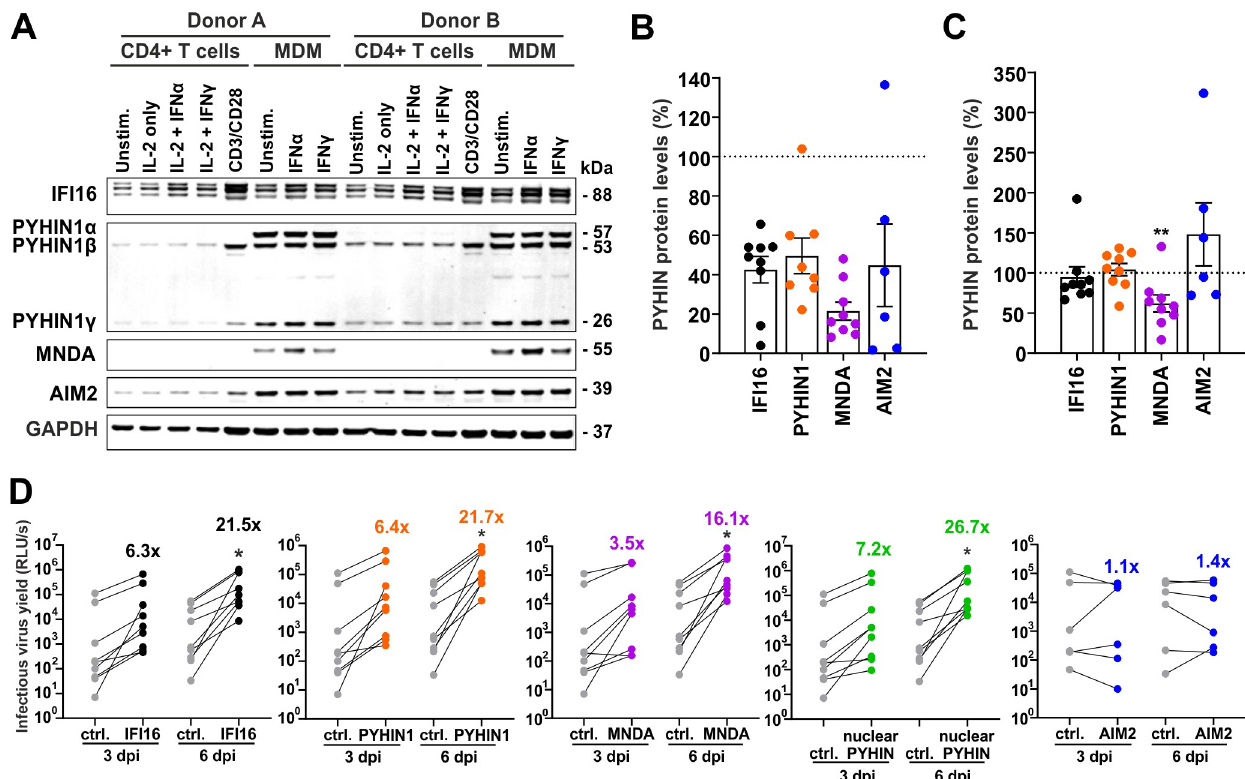
Fig 3. Nuclear human PYHIN proteins restrict HIV-1 in human macrophages. (A) Expression of PYHIN proteins in primary HIV-1 target cells. CD4+ T lymphocytes were stimulated with IL-2 alone, IL-2 + IFN α (500 U/ml), IL-2 + IFN γ (200 U/ml) or IL-2 + anti-CD3/CD28 beads. Macrophages (MDM) were stimulated with either IFN α (500 U/ml) or IFN γ (200 U/ml). 72 hours post stimulation, cells were harvested and lysed for Western Blot analysis. (B). Knock- down efficiencies in human MDM. Cells were treated with PYHIN-specific or control siRNA. Each point represents protein expression levels compared to cells treated with control siRNA (100%) obtained from one donor. (C) Expression levels of the indicated PYHIN proteins in HIV-1 infected compared to uninfected MDM cultures (100%). �� , p < 0.01. (D) Infectious virus production at 3 or 6 days post-infection (dpi) from MDM treated with the indicated siRNAs. In the nuclear PYHIN panel, siRNAs targeting IFI16, PYHIN1 and MNDA were combined. Numbers give average n-fold enhancement of infectious virus yield compared to cells treated with the control siRNA.